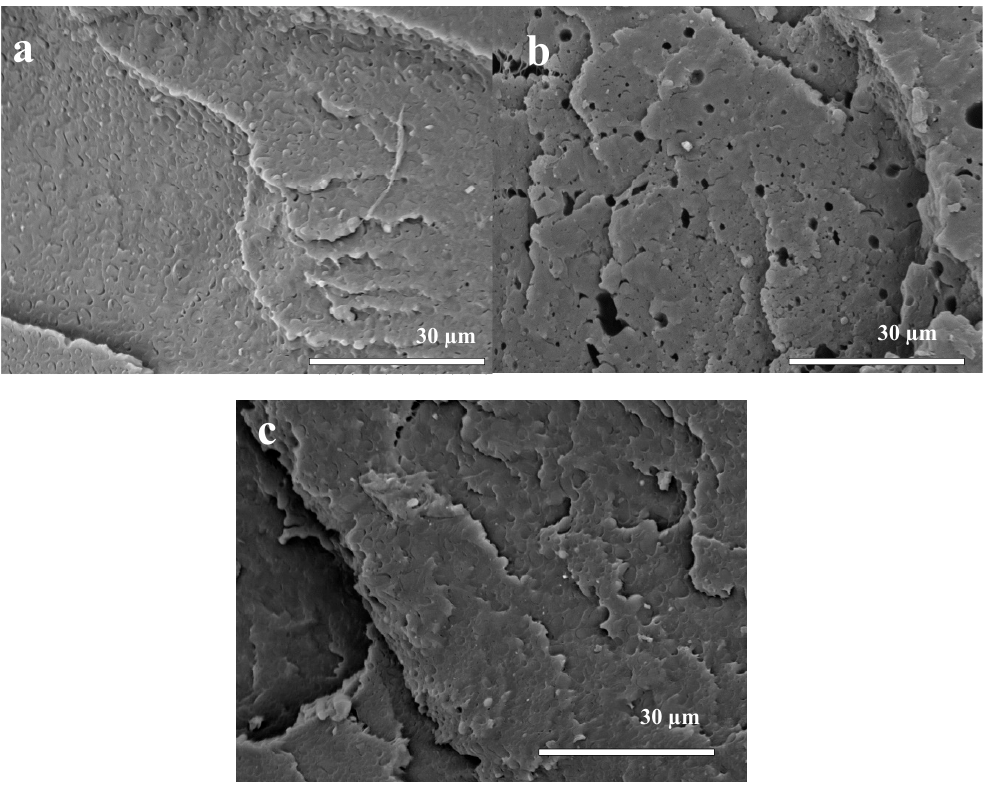
Figure 2. SEM micrographs of the (cryogenic fracture surface) of the cross-section for the bio-based polymer fibers: ( a ) FC, ( b ) FG, and ( c ) F3.